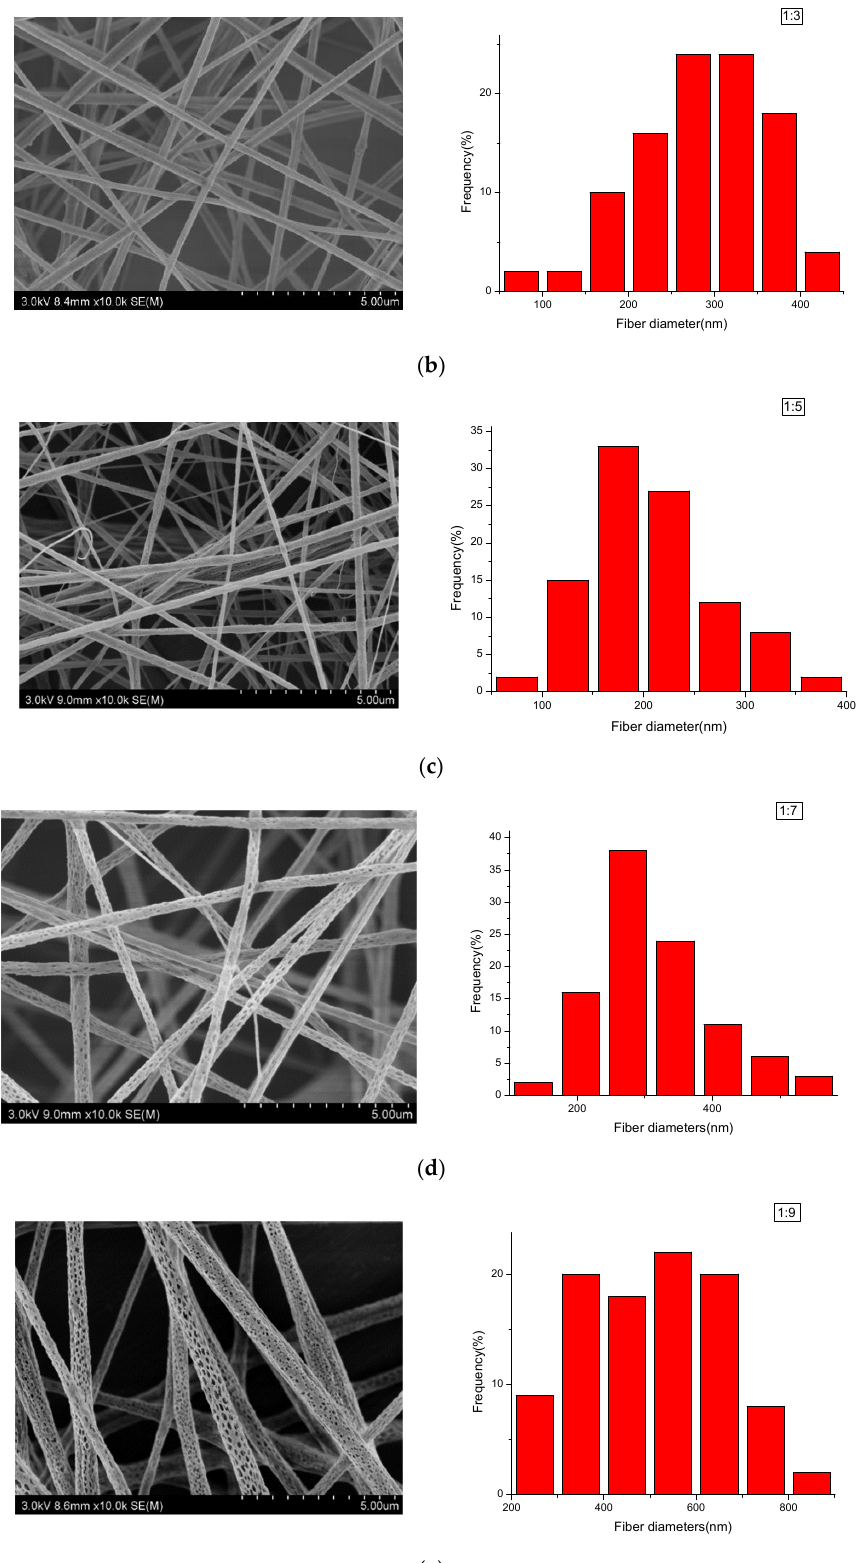
Figure 1. SEM pictures of the electrospun polylactide/polyethylene glycol/curcumin (PLA/PEG/Cur) carbon nanofibers (CNFs) with different weight ratios (PEG:PLA). The right figures were the according diameter distribution: ( a ) 1:1, ( b ) 1:3, ( c ) 1:5, ( d ) 1:7, ( e )